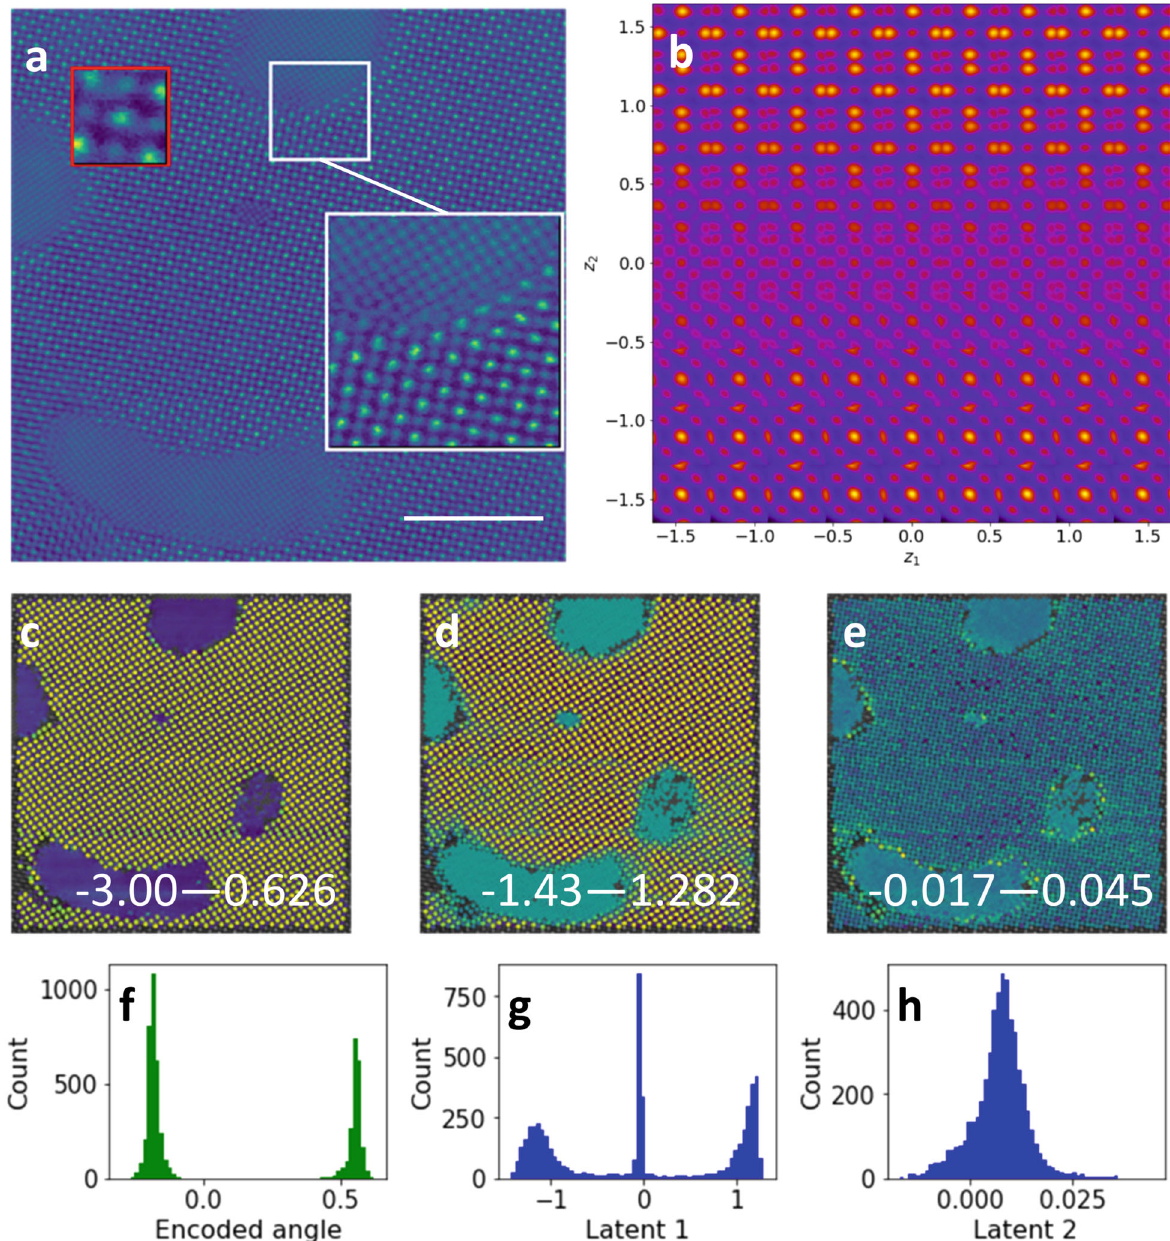
Fig. 3 rVAE analysis of multiphase (La x Sr 1- x )MnO 3 – NiO system. a The original ADF image with the white box showing an enlarged section of one of the (La x Sr 1- x )MnO 3 – NiO interfaces. The red box contains a typical frame from the stack that was used for training which was constructed using a window size of 36 pixels. The scale bar is 5 nm. b The sub-image representation in 2D latent parameter space. c The encoded angle. d, e The latent variables Z 1 and Z 2 . Insets in c , d show range of variation in image intensities. f – h The histograms of the intensity distributions corresponding to ( c – e Fig. S4j, k all clearly differentiate between the two phases though variables, visualized both as individual points and with a super- the latent variables have little structure in the perovskite phase. imposed kernel density estimate (KDE). Note that each point What is notable however is that the scan distortions are clear in all corresponds to the sub-image and describes the behavior of the three. The histogram of the encoded angle in Fig S4i has collapsed local neighborhood of a single lattice atom. The representation as to a single sharp peak. The fi rst latent space histogram has two points and KDE allows the comparison between the total system overlapping peaks consistent with the coloration of the two behavior (including the distribution of outliers) and the corre- phases, while the second has a single broad peak. sponding densities (average behaviors) and is necessary given the The structure of the distributions in the latent space of rVAE was large number of points (from ~10 4 for single images to ~10 5 for used to gain further insight into the analysis, as shown in Fig. 4. the stacks). To extend this analysis, we note that the rVAE often tends to The latent space distribution exhibits extremely interesting disentangle dissimilar types of distortions within a system. behavior. Figure 5a shows the joint distribution of the latent